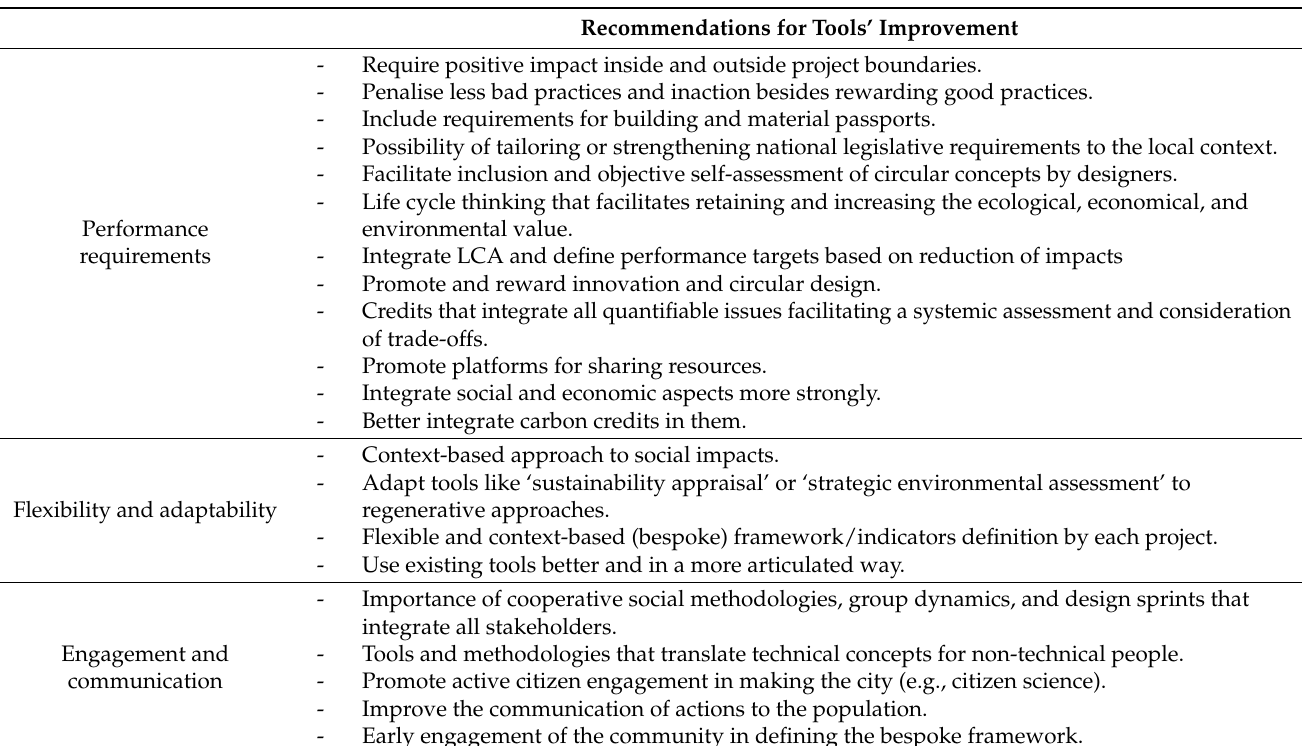
Table 7. Summary of identified opportunities to enable a RC4BE. Recommendations for Tools’